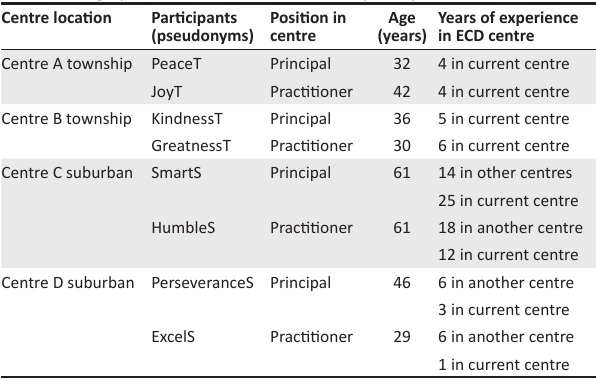
TABLE 1: Biographic information of centres and participants. Centre location Participants Position in (pseudonyms)